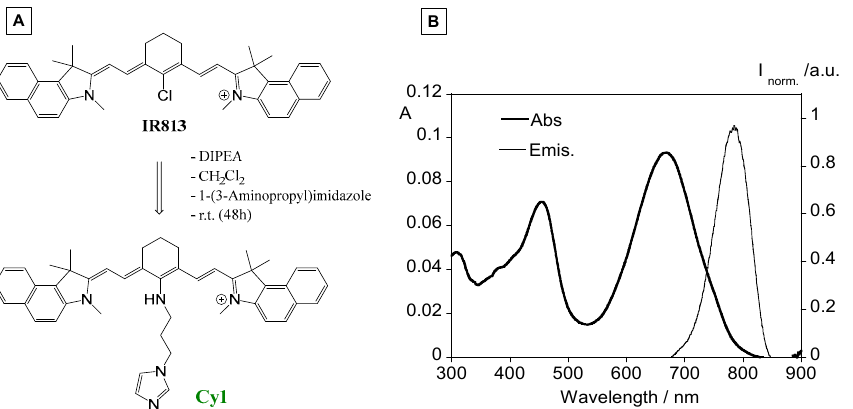
Figure 1. ( A ) General synthetic pathway for Cy1 . ( B ) Absorption and emission spectra of Cy1 in acetonitrile. [ Cy1 ] = 5.8 × 10 − 6 M, λ exc. = 668 nm.